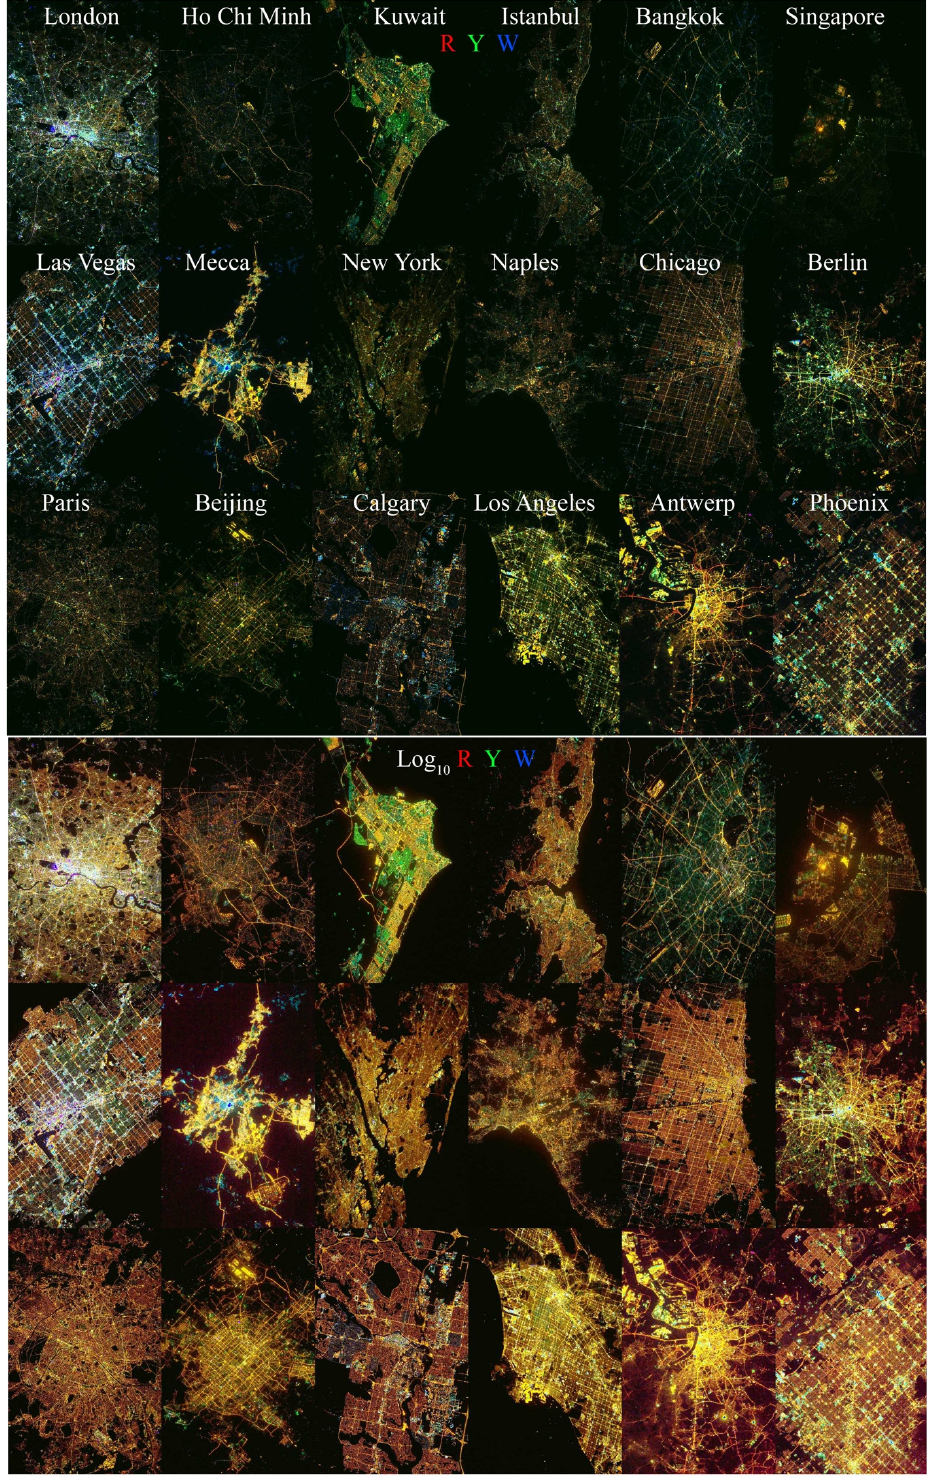
Figure 7. Spectral endmember fraction mosaics of 18 cities. The 5500 K mosaic is unmixed with a 4-endmember linear mixture model with white, yellow, red and dark endmembers. As the dark endmember fraction modulates luminance, an RGB composite of the R, Y and W fractions ( top ) resembles the 5500 K RGB composite in Figure 5. The RGB composite of Log 10 (R, Y, W) ( bottom ) partially offsets this dark fraction modulation to enhance the lower luminance mixed spectra. Both mosaics displayed with a 1% linear stretch